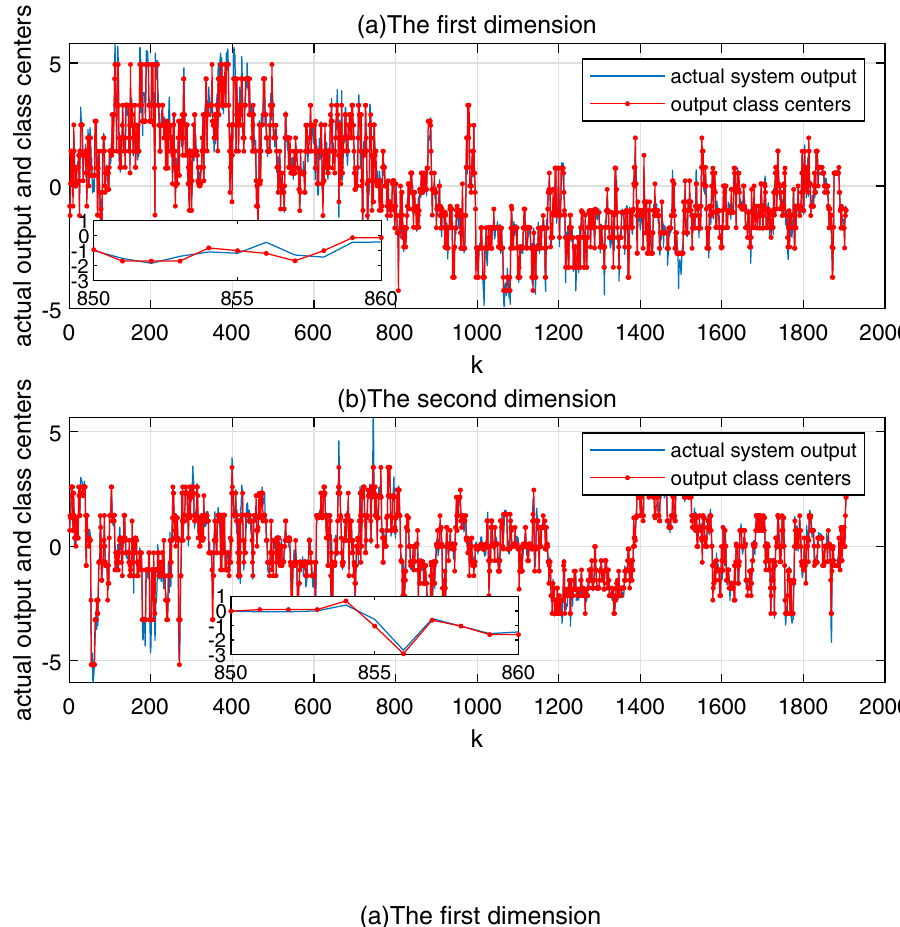
Fig. 6 Validity verification of the initial control